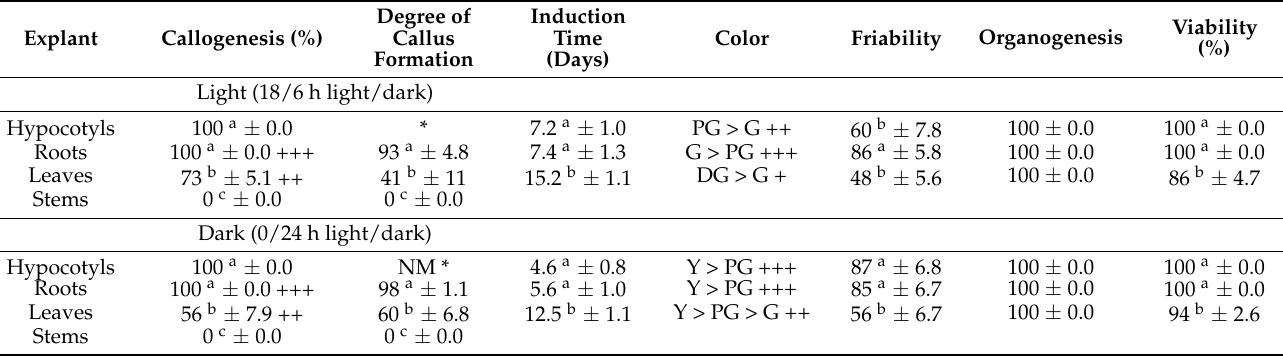
Table 1. Developmental and morphological parameters of T. officinale callus four weeks after induction for different explant types and photoperiod (medium MS supplemented with sucrose 2.3%, 0.1 mg/L of NAA, and 2.0 mg/L of BAP).